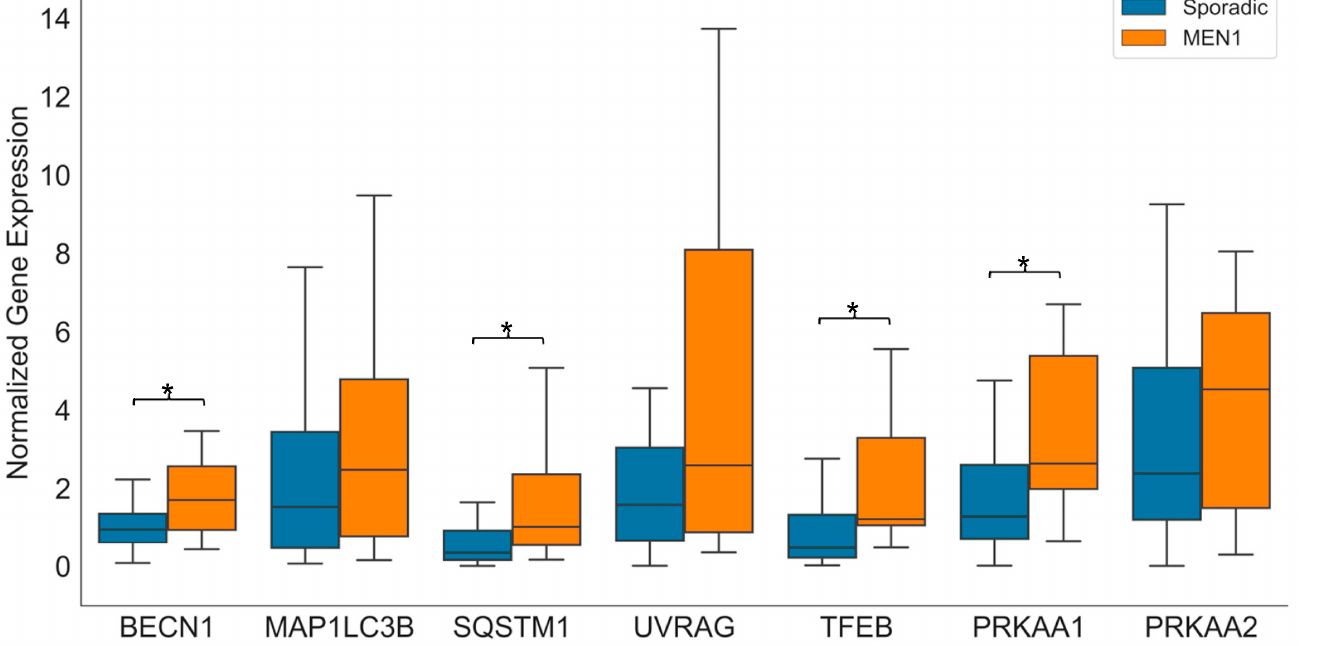
Figure 1. Box and whisker plot showing the expression of autophagic gene transcripts in sporadic pNEN ( n = 40) and MEN1-associated pNEN ( n = 14). * p < 0.05 was considered significant (two-sided Mann–Whitney U test). MEN1 = multiple endocrine neoplasia type 1. Table 2. Prognostic value of patient’s characteristics and autophagic transcript expression regarding overall survival in pNEN ( n = 54). * p < 0.05. Due to the high rate of loss to follow-up (18%), the risk of poor validity must be